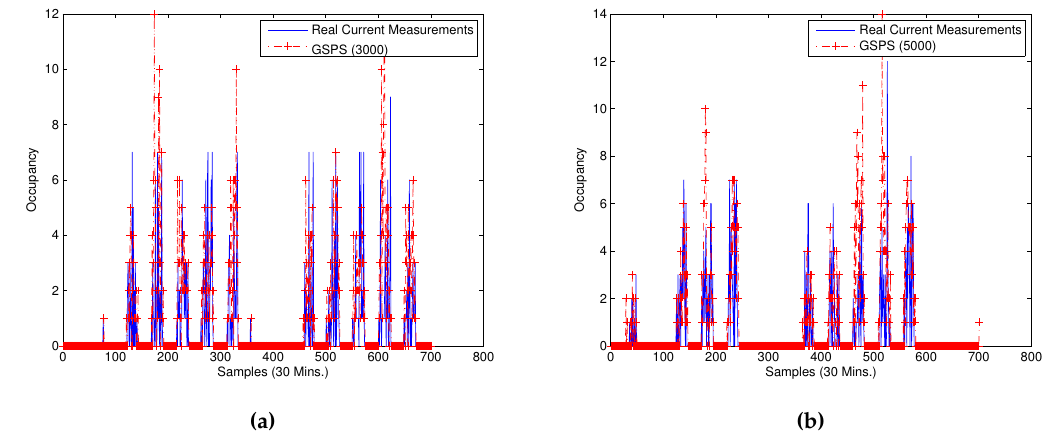
Figure 5. Occupancy estimation using GSPS model: ( a ) Occupancy estimation using GSPS model 3000 points; ( b ) Occupancy estimation using GSPS model 5000